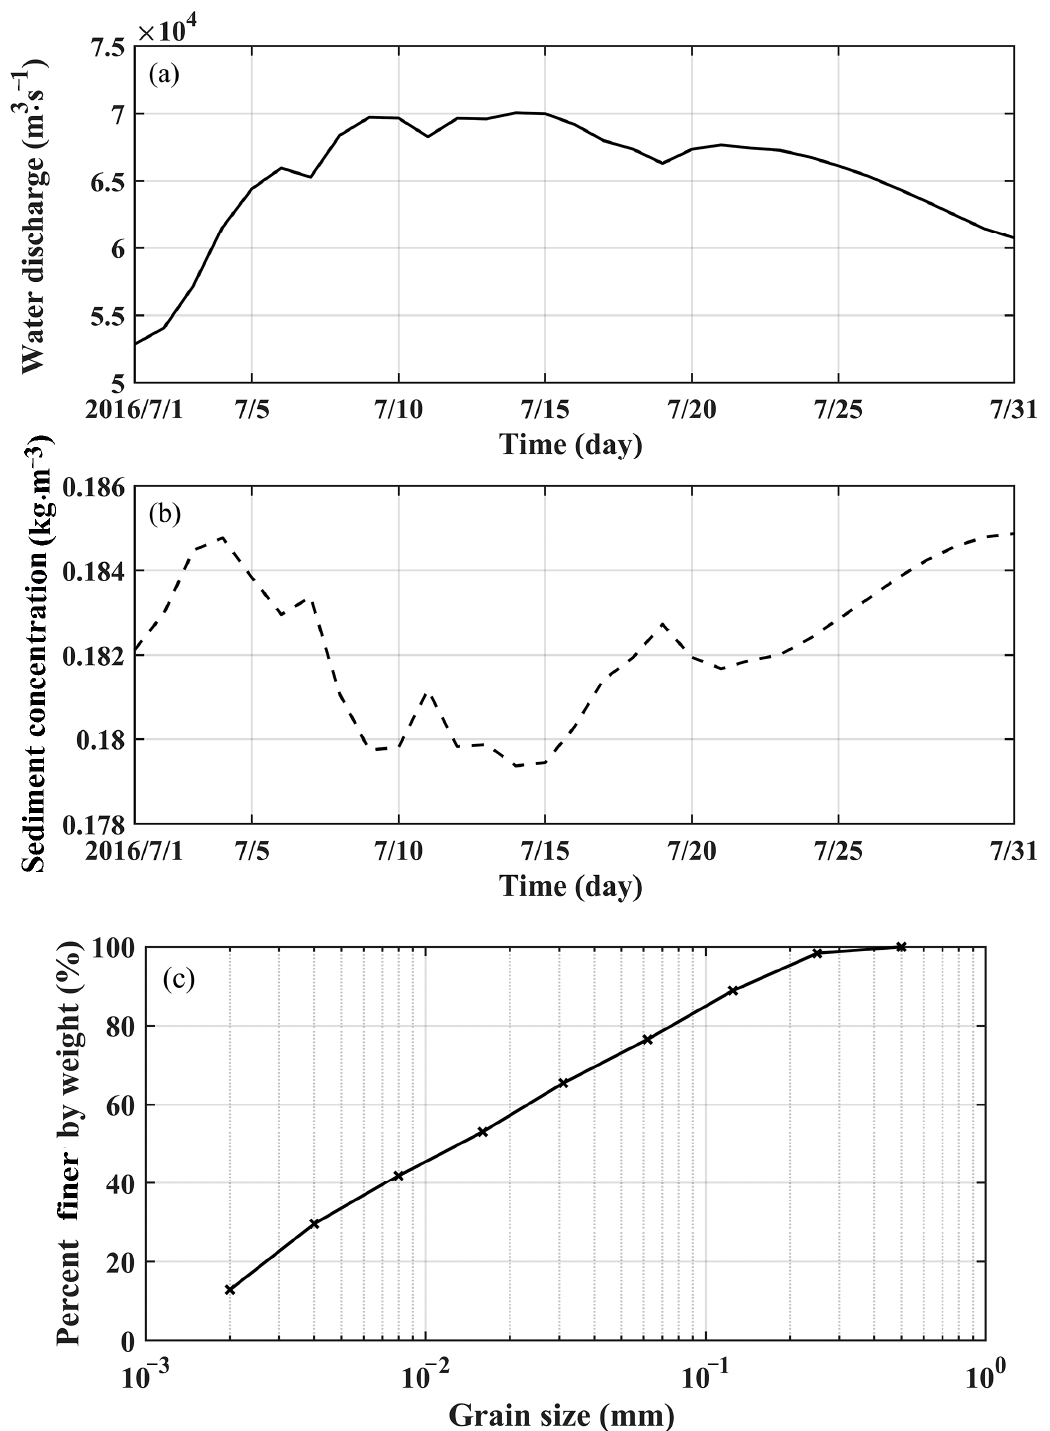
Figure 5. Basic details of water discharge, sediment concentration, and composition. ( a ) Water discharge of the Yangtze Estuary during July 2016; ( b ) the sediment discharge at Datong station during July 2016; ( c ) the averaged riverine suspended sediment compositions at Datong in July from 2004 to 2010.